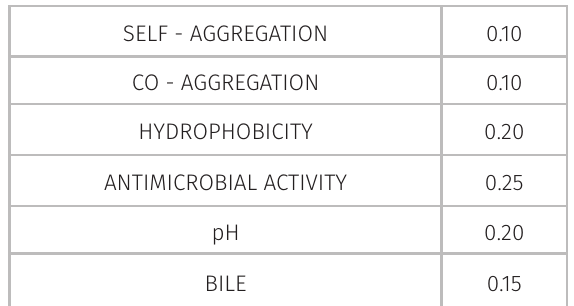
Table I. Importance coefficients established for each property